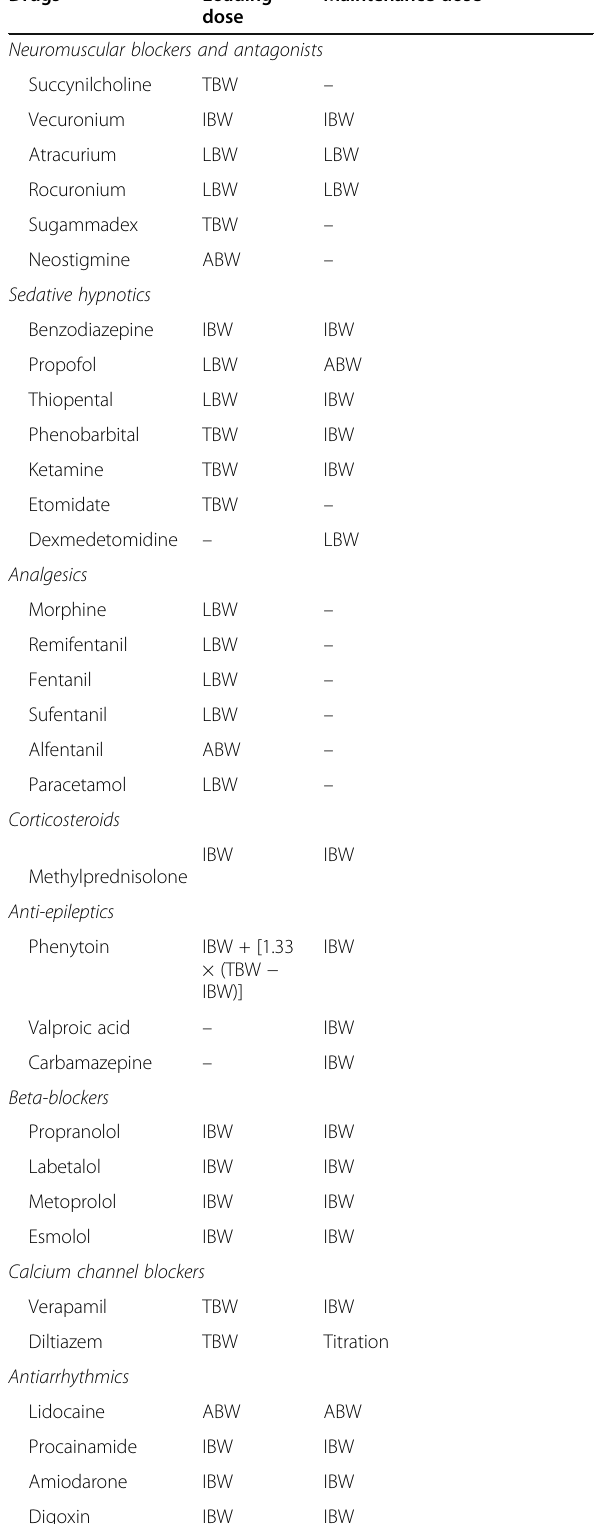
Table 2 Emergency drug dosing in obese patients. Adapted from Cataldo et al. [72]